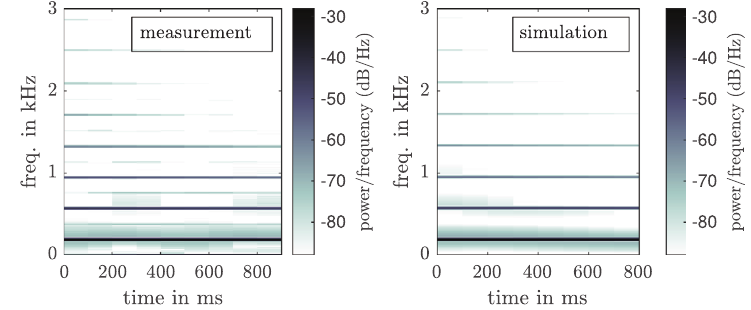
Figure 11. Spectrogram of the measured signal (left) and of the simulated signal (right).